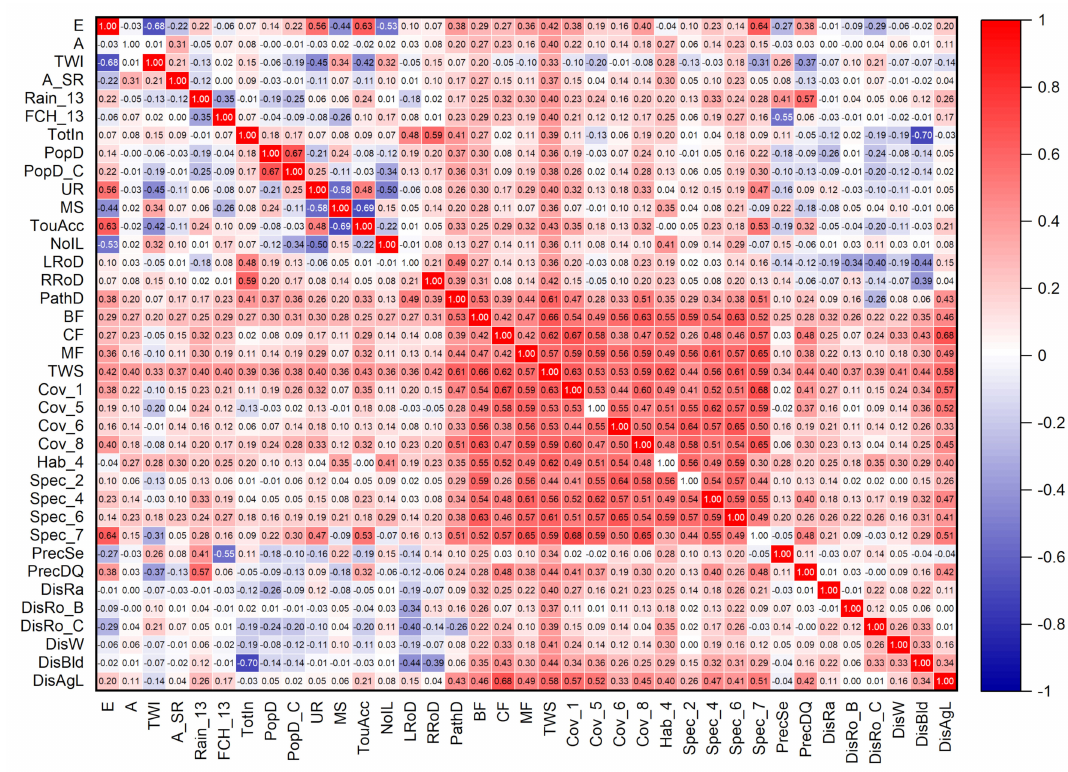
Figure A1. Correlation plot for all preselected variables based on Spearman’s rho